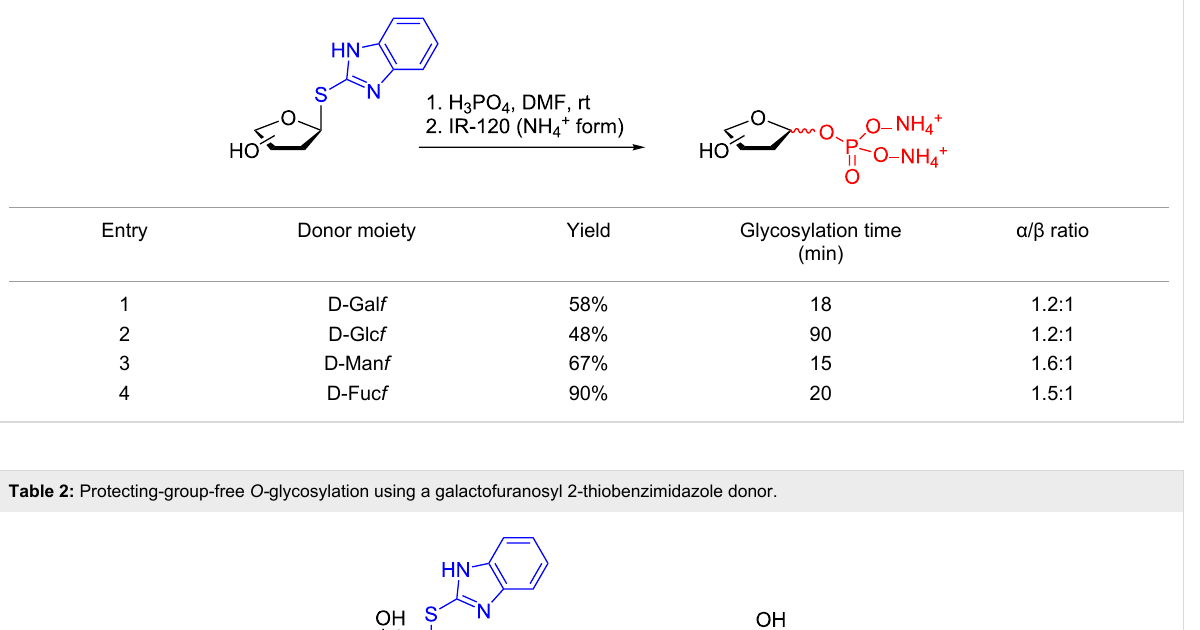
Table 1: Protecting-group-free synthesis of hexofuranosyl 1-phosphates from hexofuranosyl 2-thiobenzimidazole donors using remote activation.